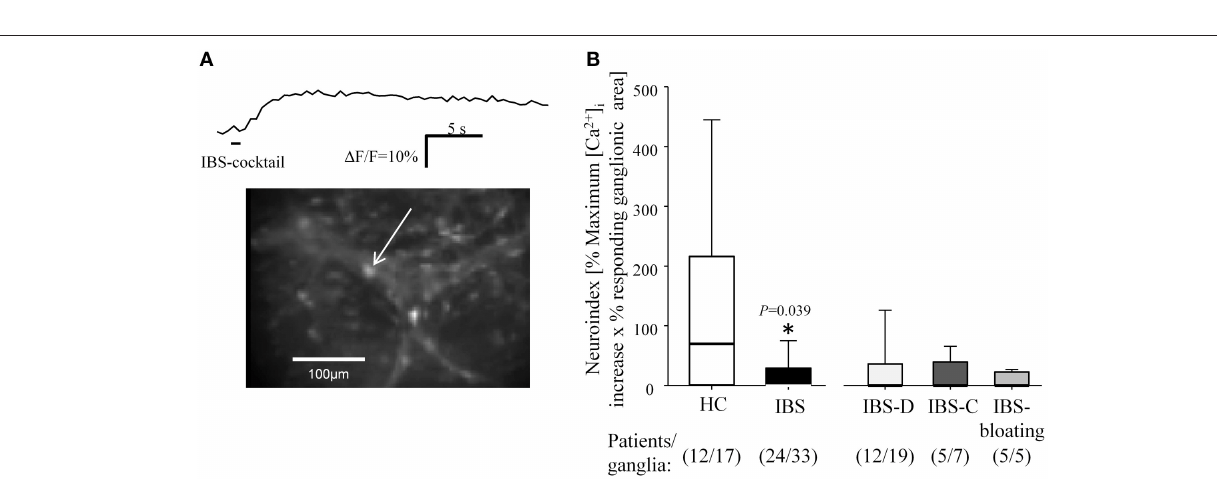
FIGURE 3 | Neuronal response to the spritz application of an IBS-cocktail on submucous ganglia in IBS and HC biopsies. (A) Submucous ganglion stained with the calcium-sensitive dye Fluo-4 AM. The trace reflects [Ca 2 + ] i increase in response to application of the IBS-cocktail in the cell marked by the white arrow. (B) The IBS-cocktail evoked significantly smaller neuronal activation in ganglia from IBS biopsies as indicated by the reduced neuroindex ( * p < 0.05 ). There was no significant difference between the subtypes IBS-D, IBS-C, and